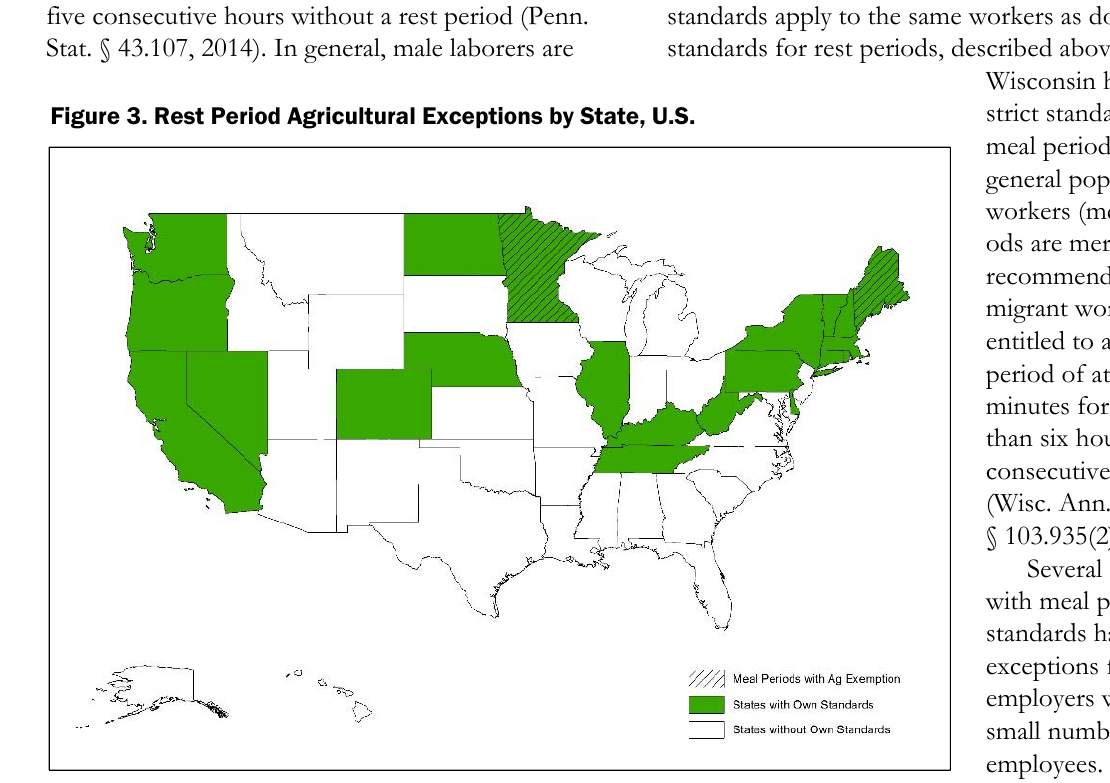
Image created by Johns Hopkins Center for a Livable